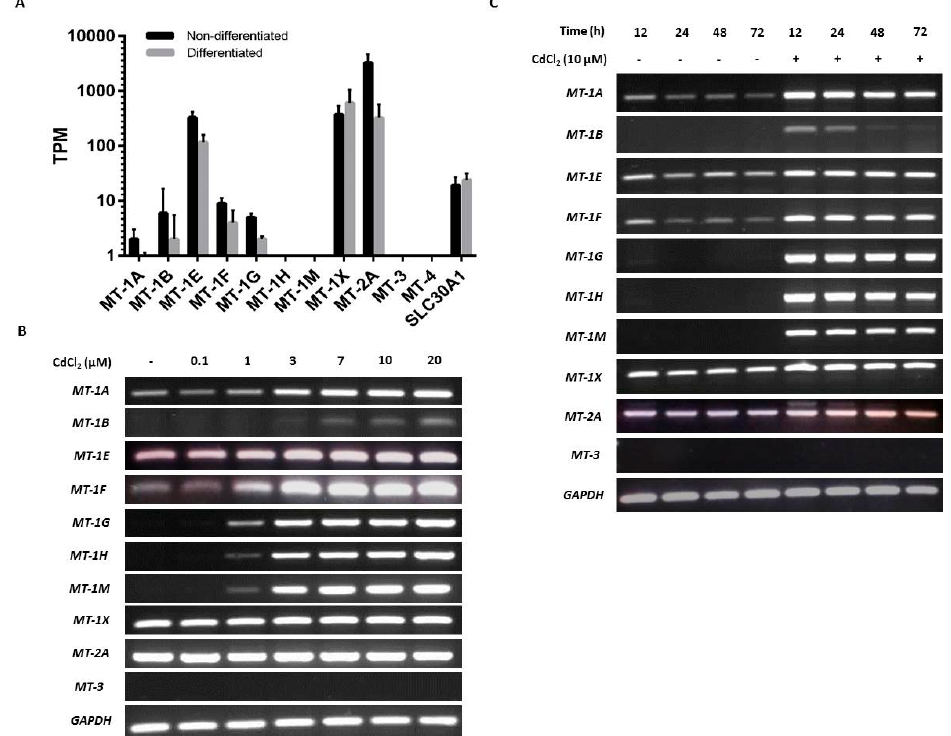
Figure 2. Baseline and cadmium-induced MT transcript expression by NHU cells in vitro. ( A ) Next- generation sequencing data showing baseline MT isoform transcription in nondifferentiated and differentiated NHU cells ( n = 3 independent cell lines; standard deviation is shown). ( B,C ) MT gene